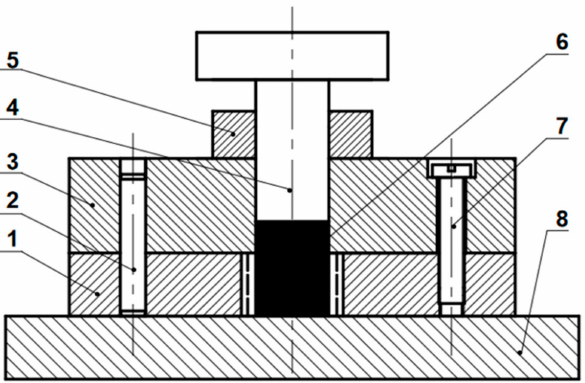
Figure 2. Tool structure assembly drawing of the bimetal gear hot forging process: 1 toothed die, 2 pin, 3 sleeve, 4 top punch, 5 stop block, 6 billets, 7 screw, 8 workbench. Table 2. Processing plans of three bimetallic gears with different degrees of deformation. Exp.